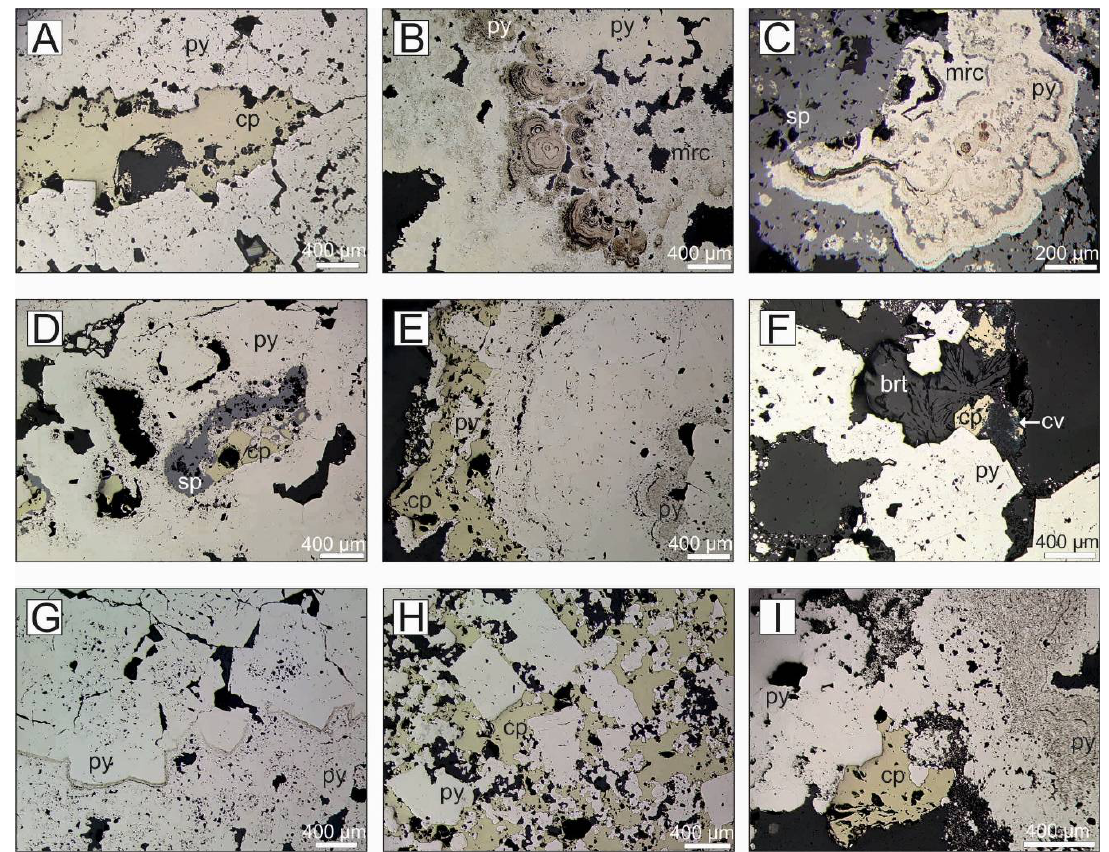
Figure 8. Reflected light photomicrographs of representative mineral assemblages and textures from drill core samples obtained during JC138. ( A ) Massive recrystallized pyrite with intercalated layers of chalcopyrite (Southern M., 50-14, 6.63–6.73 mbsf). ( B ) Colloidal pyrite overgrown by marcasite and later pyrite (Rona M., 57-12, 6.37–6.48 mbsf). ( C ) Framboidal pyrite overgrown by rhythmic bands of colloform marcasite and sphalerite and surrounded by sphalerite (Rona M., 57-19,